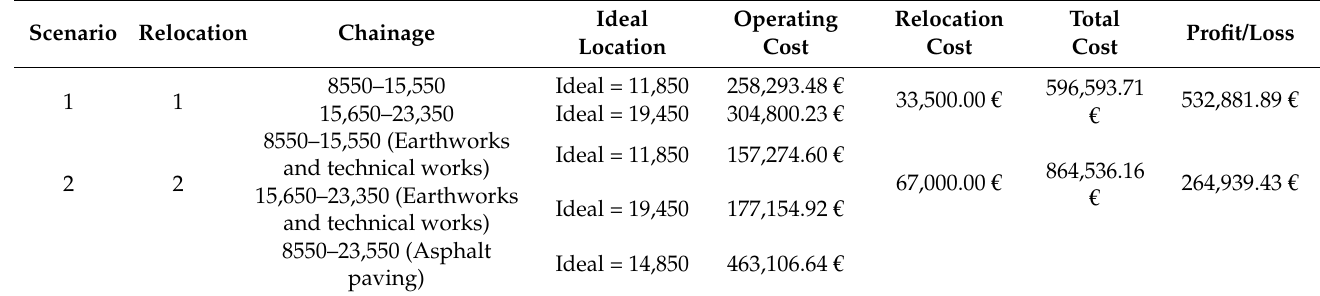
Table 7. Profit gained in case of changing sequence of